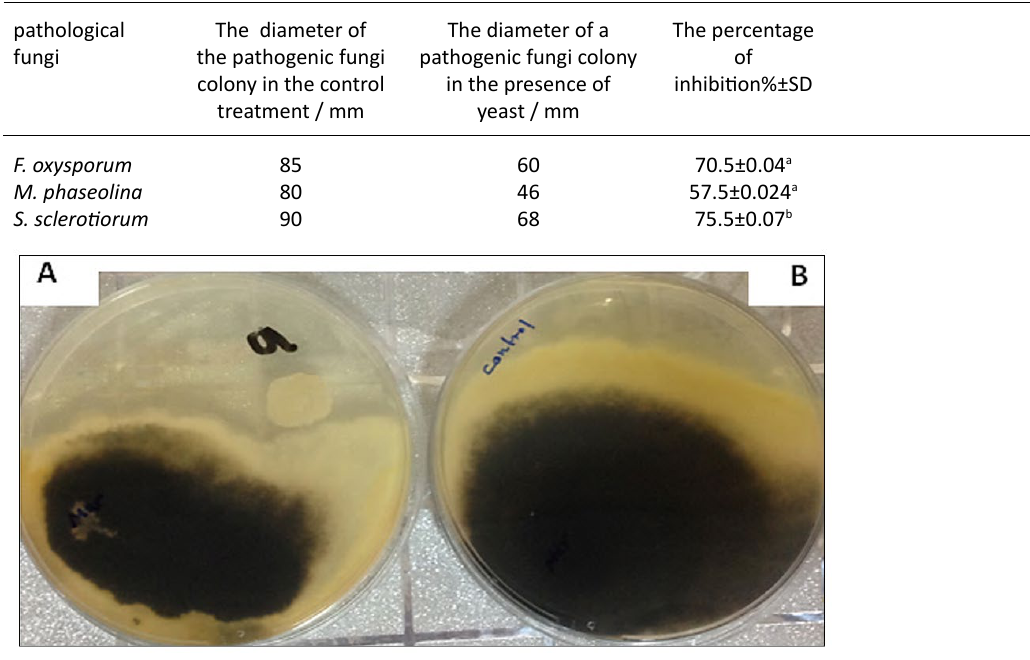
Fig. 3. A- The diameter growth of M. Phaseolina with the presence of K. marxianus yeast as a biological control agent. B- Shows the diameter growth of M. phaseolina without the presence of yeast (control treatment). The Petri dishes were grown and incubated at 25±2°C using the PDA culture medium for seven